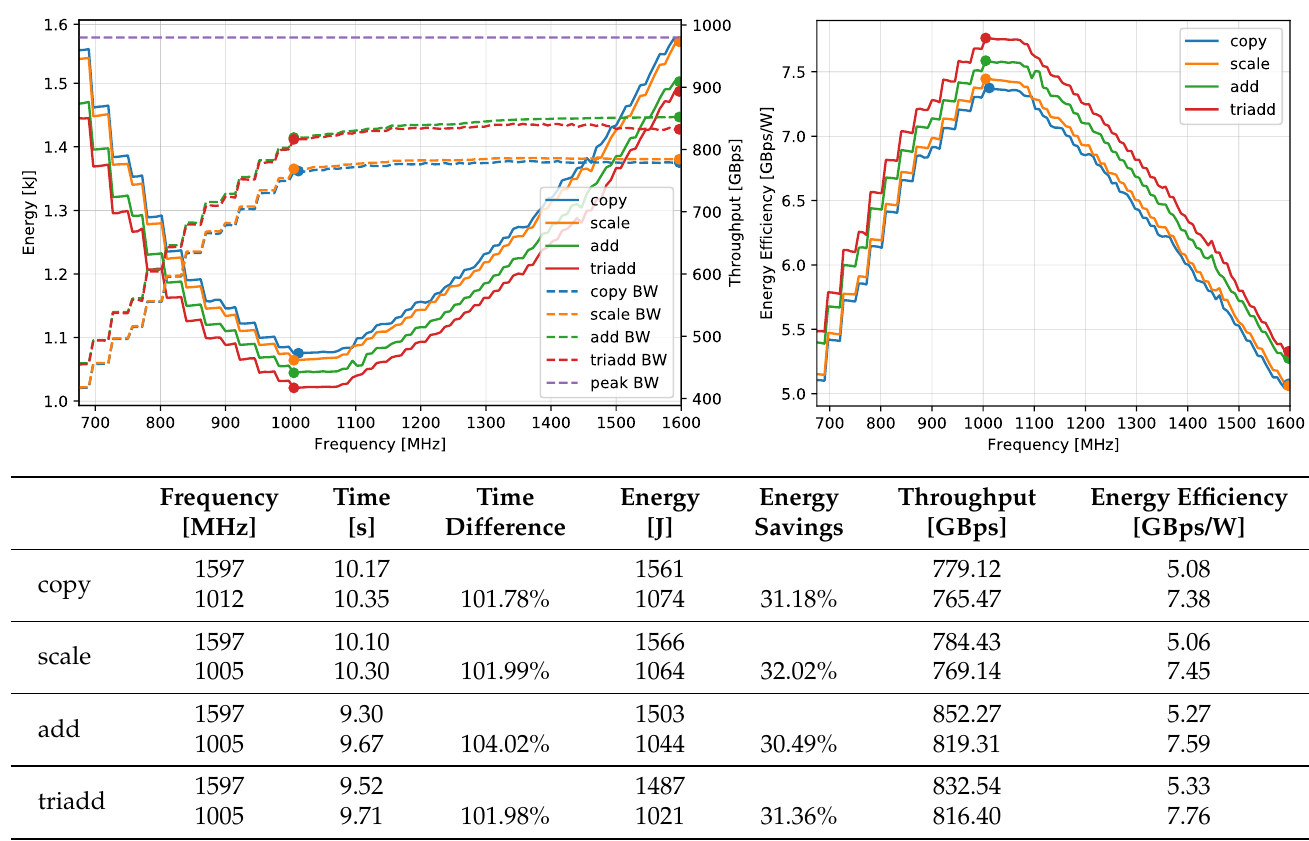
Figure 10. DGX-2 frequency scaling of the STREAM benchmark. The plot on the left shows consumed energy and throughput. The plot on the right shows the energy efficiency. The table at the bottom shows the time difference, energy savings, and energy efficiency of the STREAM benchmark at the base and at the optimal frequency. The marker in the plot highlights the two frequencies from the